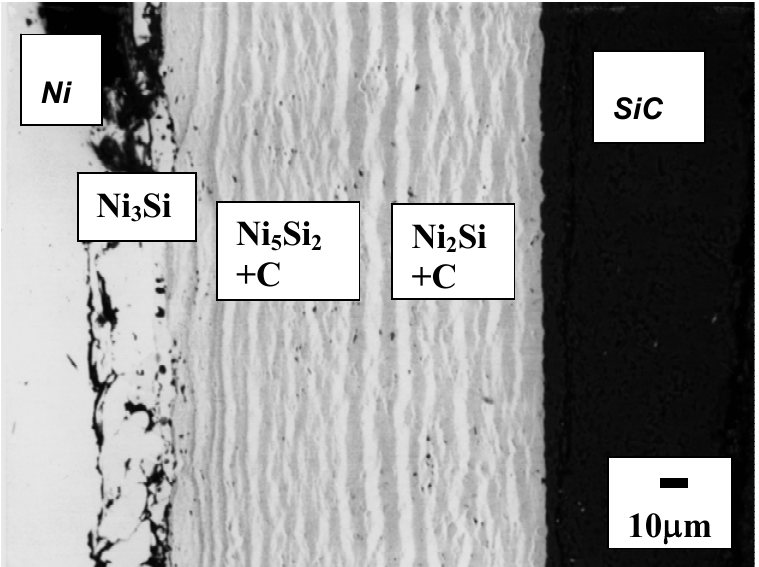
Figure 5. Back Scattered Electron image of Ni/SiC reaction couple annealed at 900 ° C for 40 h